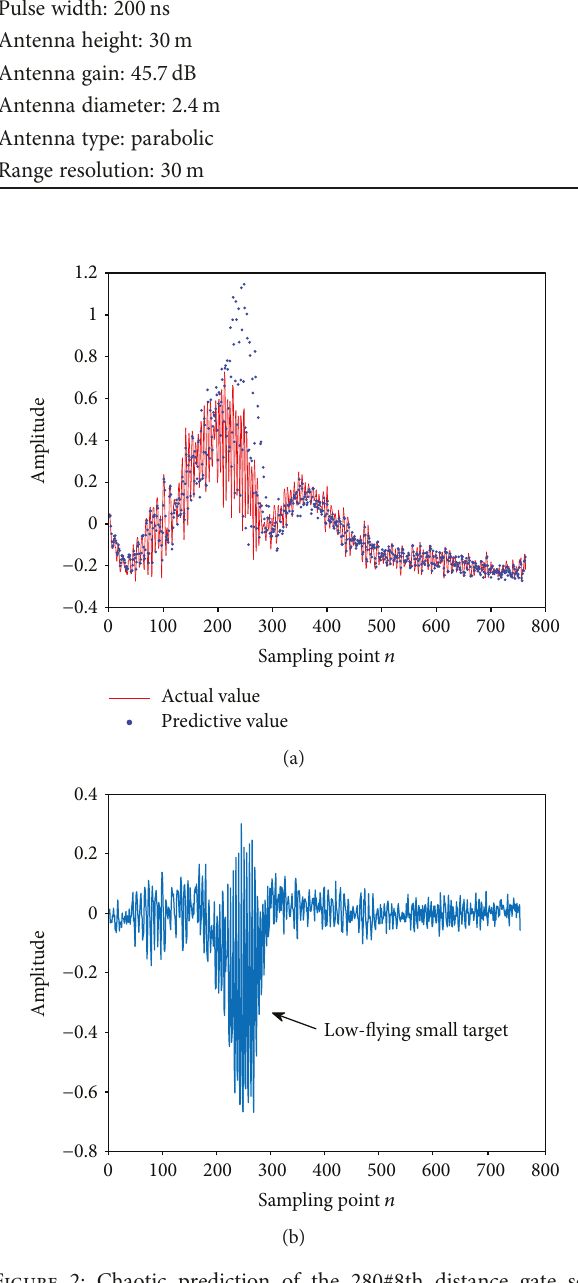
Figure 2: Chaotic prediction of the 280#8th distance gate sea clutter. (a) Actual value and Volterra predicted value. (b) The prediction